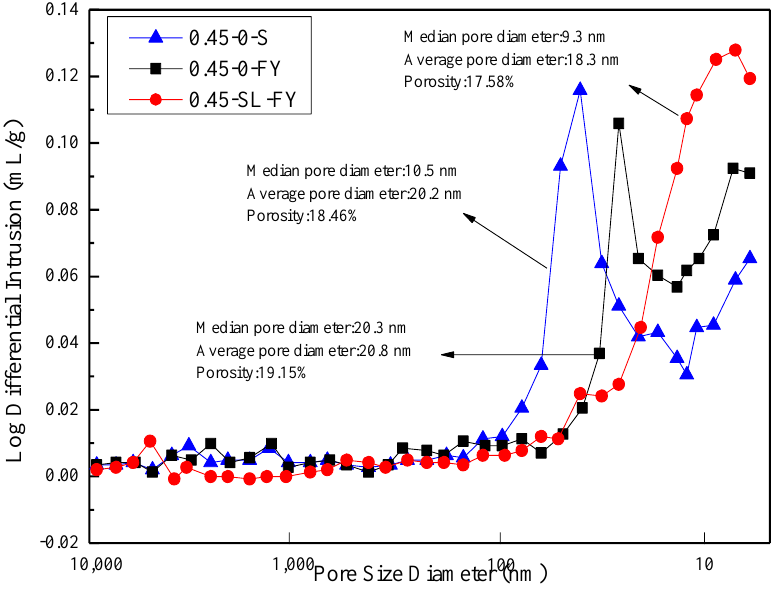
Figure 10. Log differential intrusion of concrete at 180 d.